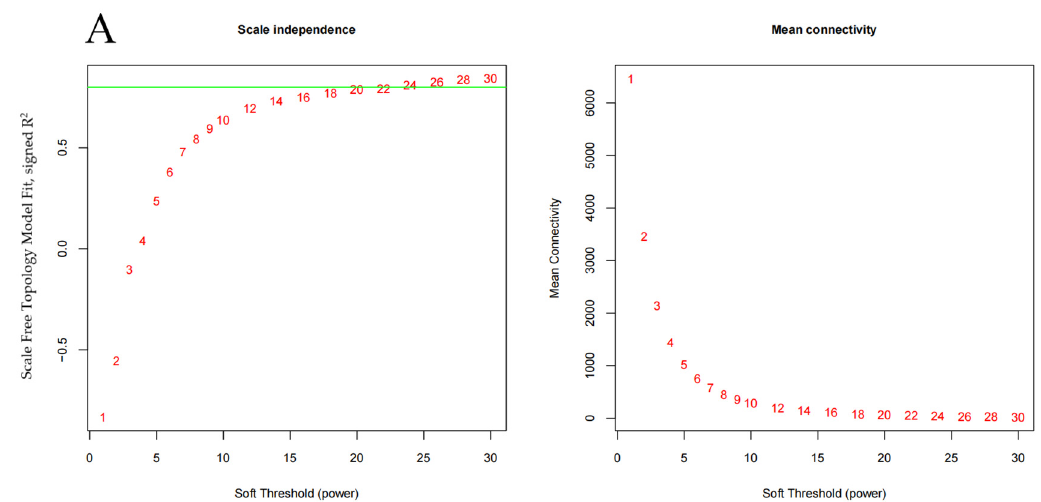
Figure 5. The KEGG mapper of neuroactive ligand–receptor interaction. The green boxes represent genes in Profile 19 which are enriched in this pathway.